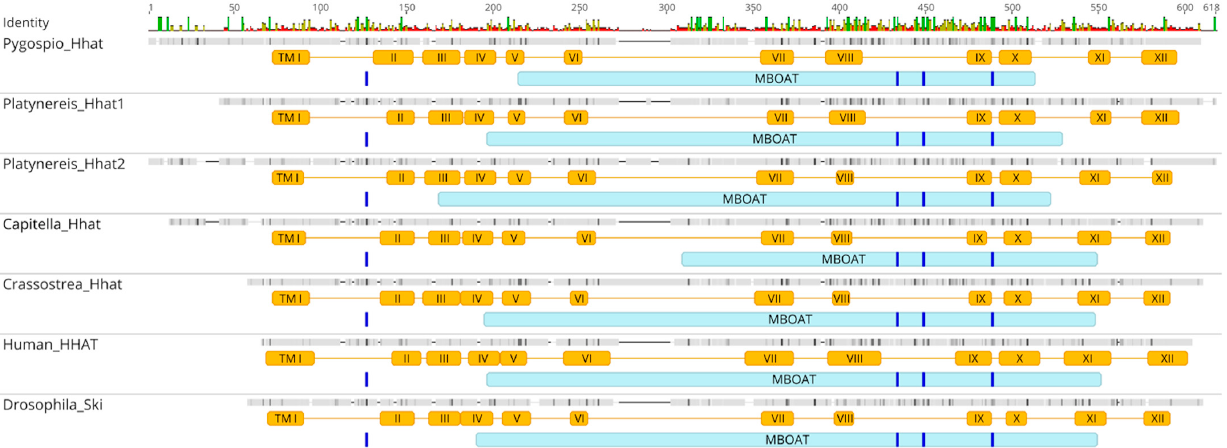
Figure 3. Multiple sequence alignment of Skinny/Hhat proteins. Skinny hedgehog and human HHAT contain 12 transmembrane helices (TM) and an MBOAT domain, which lies in the TM4–TM11 portion of the protein. In human HHAT, mutations at four sites (Glu59, Cys324, Asp339, and His379) reduce protein activity, and these residues are conserved between fruit fly and vertebrates [61]. Spiralian Hhat proteins share a similar domain structure and include conserved sites (indicated by blue bars) essential for Hhat activity. TM (I–XII), transmembrane domains.